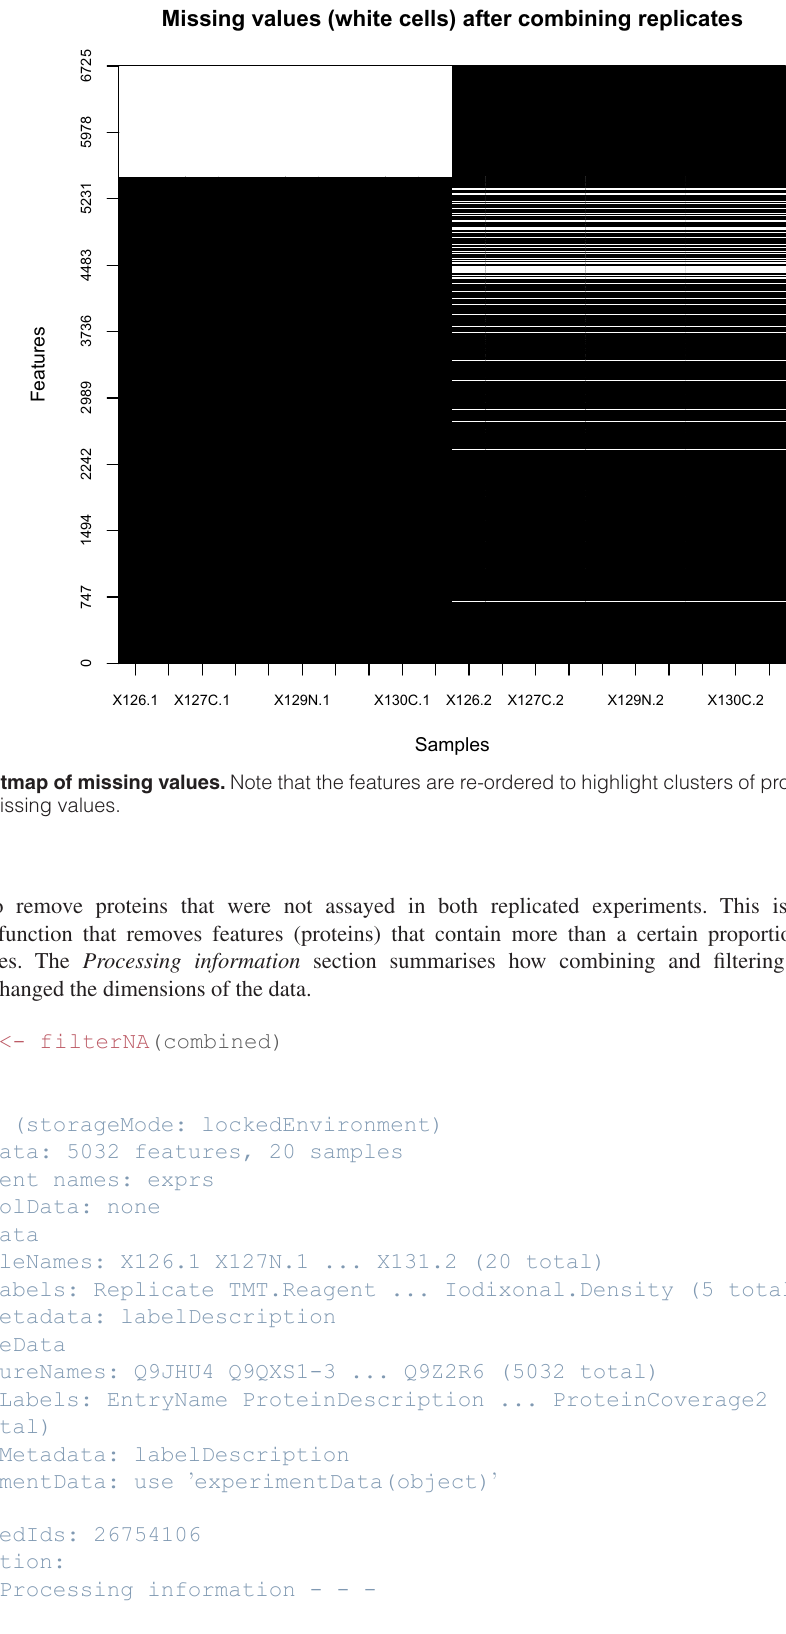
Missing values (white cells) after combining replicates